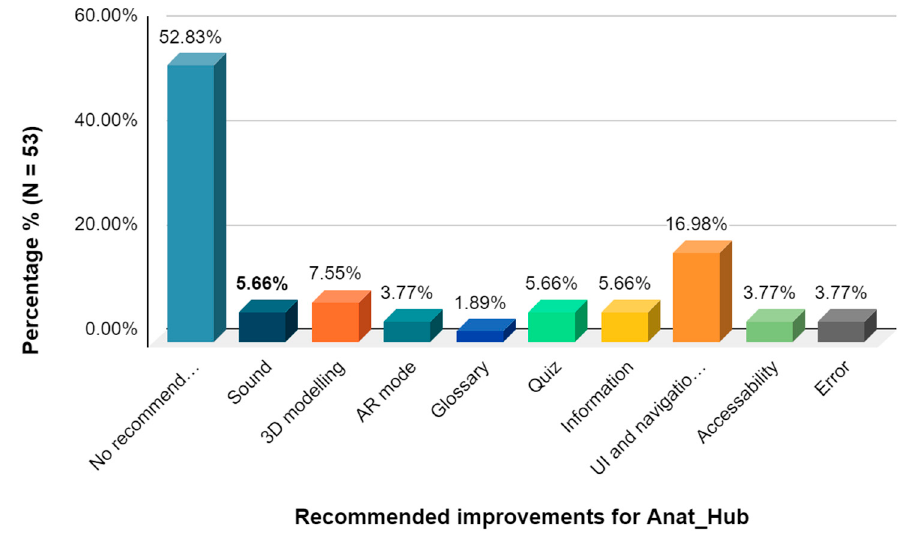
Figure 19. General recommendations for improving the Anat_Hub mobile application.